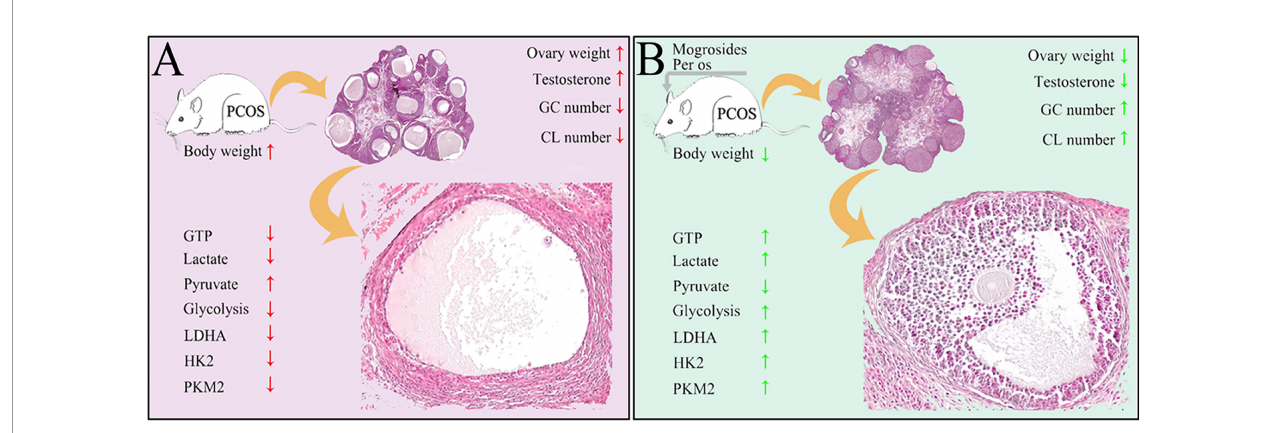
FIGURE 6 | Schematic illustrating the protective roles of MV on follicular development and ovulation of PCOS rats possibly through regulating the glycolysis pathway. (A) Ovarian damages caused by the treatment of high-fat diet and letrozole in PCOS rats. Red arrows present bad effects (with signi fi cant difference to control) on ovarian function. (B) The restoring functions of MV to ovarian damages of PCOS rats. Green arrows mean obvious improvement after MV treatment. GC, granulosa cell. CL, corpus